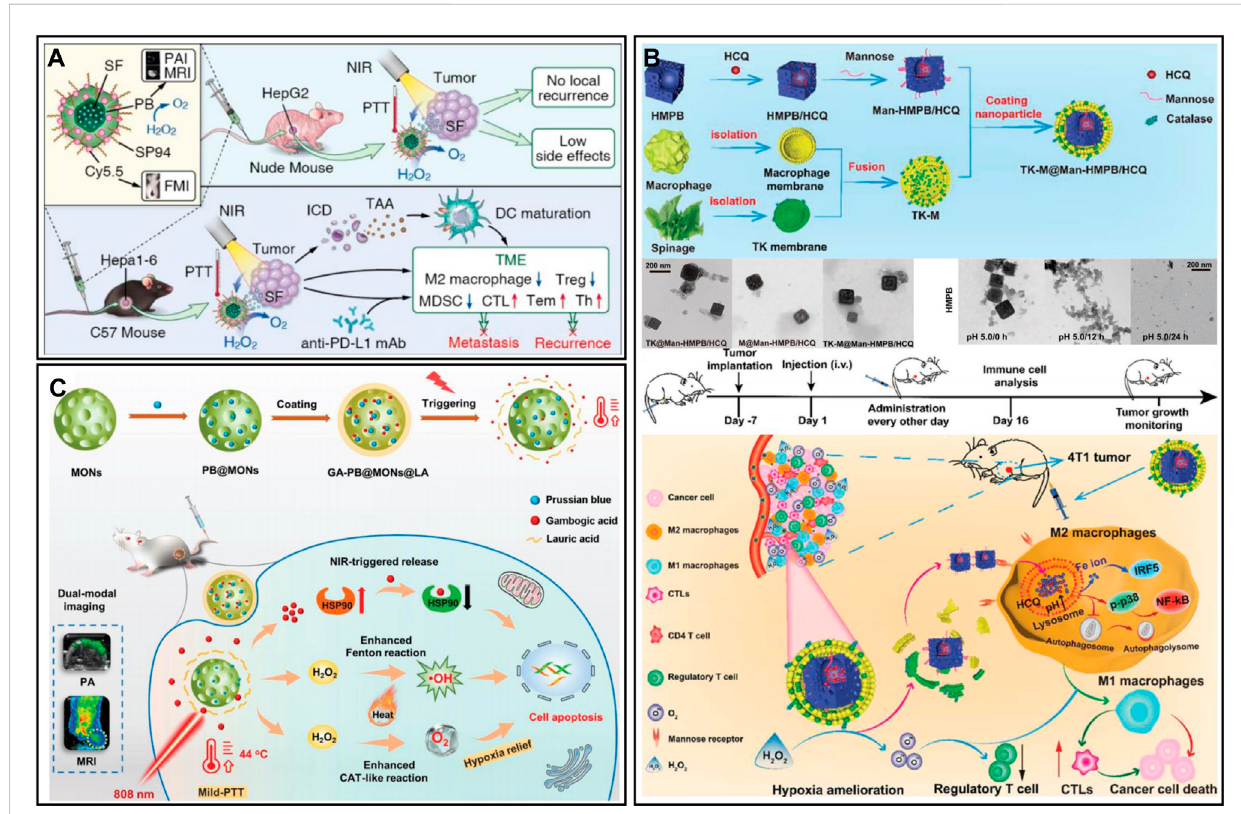
FIGURE 7 (A) SP94-PB-SF-Cy5.5 for tumor photothermal therapy and immunotherapy. Reproduced from ref. (Wang et al., 2022a) with permission from ACS Publications, copyright 2020. (B) GA-PB@MON@LA for synergistic photothermal and nanocatalytic therapy. Reproduced from ref. (Zhou et al., 2020b) with permission from Wiley, copyright 2022. (C) TK-M@Man-HMPB/HCQ for macrophage polarization and hypoxia relief. Reproduced from ref.